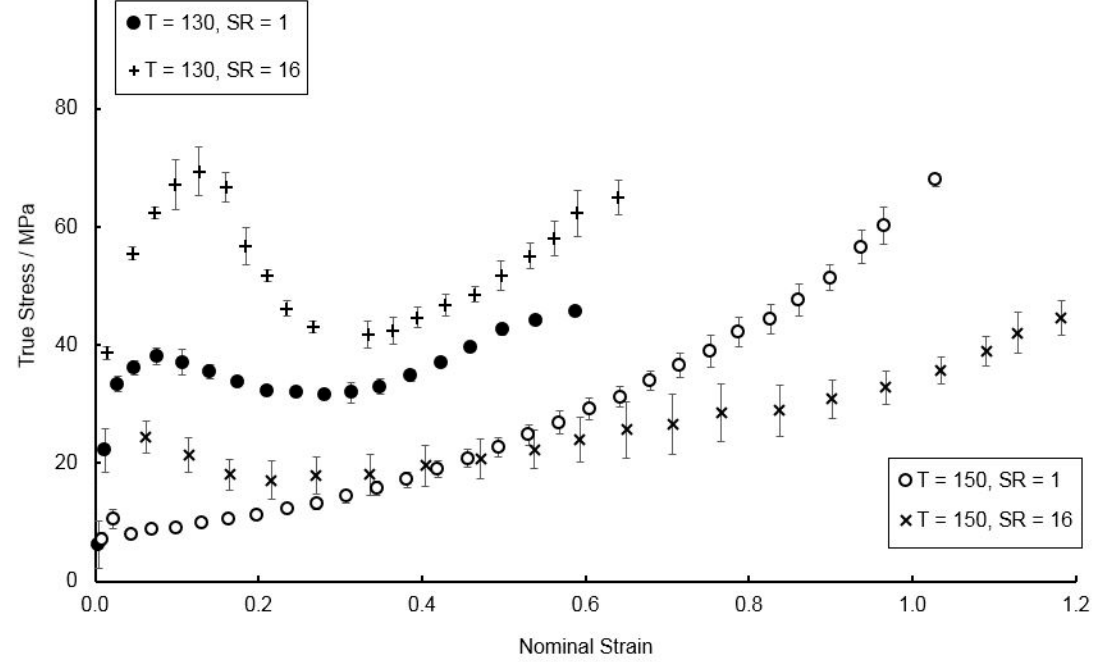
Figure 5. Influence of strain rate on resultant stress-strain behaviour at temperatures of 130 and 150 °C in the machine direction (MD).